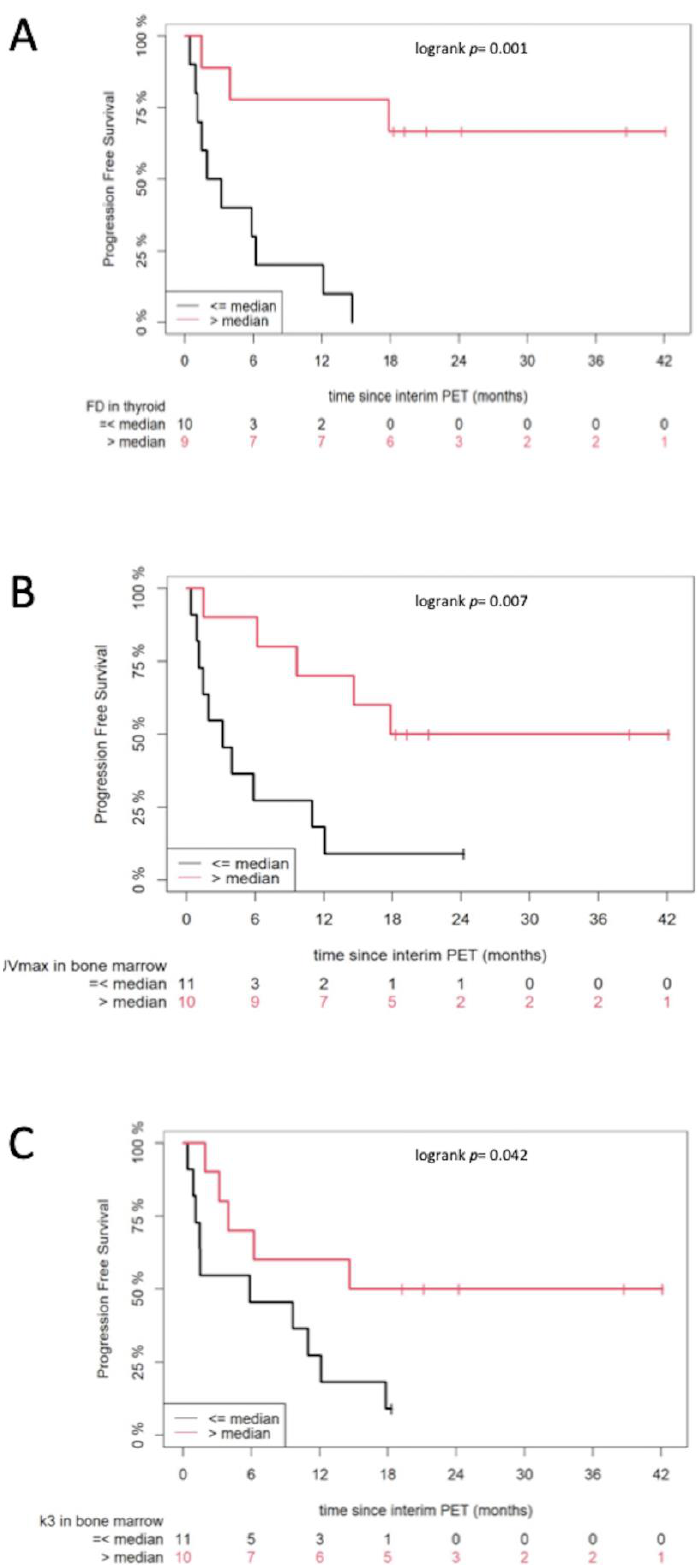
Figure 2. Kaplan–Meier estimates of PFS according to FD derived from the thyroid ( A ), as well as SUV max ( B ) and k 3 ( C ) derived from the bone marrow, on interim positron emission tomography/computed tomography (PET/CT). The numbers of patients at risk in each group and for the respective time-points are shown below the